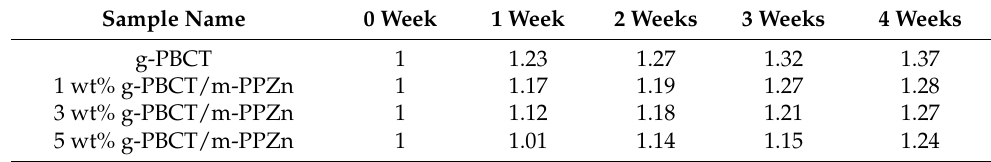
Figure 8. Change of carbonyl index of g-PBCT and various weight ratios of g-PBCT/m-PPZn composites at different UV irradiation times. Table 1. Carbonyl index * of g-PBCT/m-PPZn composites after 4 weeks UV